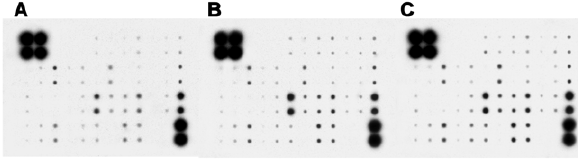
Figure 3. Antibody chip profiling of pro-inflammatory cyto- kines in blood of BIA, CIA and BIA-CIA mice. A. BIA mice; B. CIA mice; C. BIA-CIA mice. For protein extraction and antibody hybridiza- tion, whole blood was collected from mice after modeling for 28 d, and 40 kinds of cytokines, chemokines and receptors were quantitatively